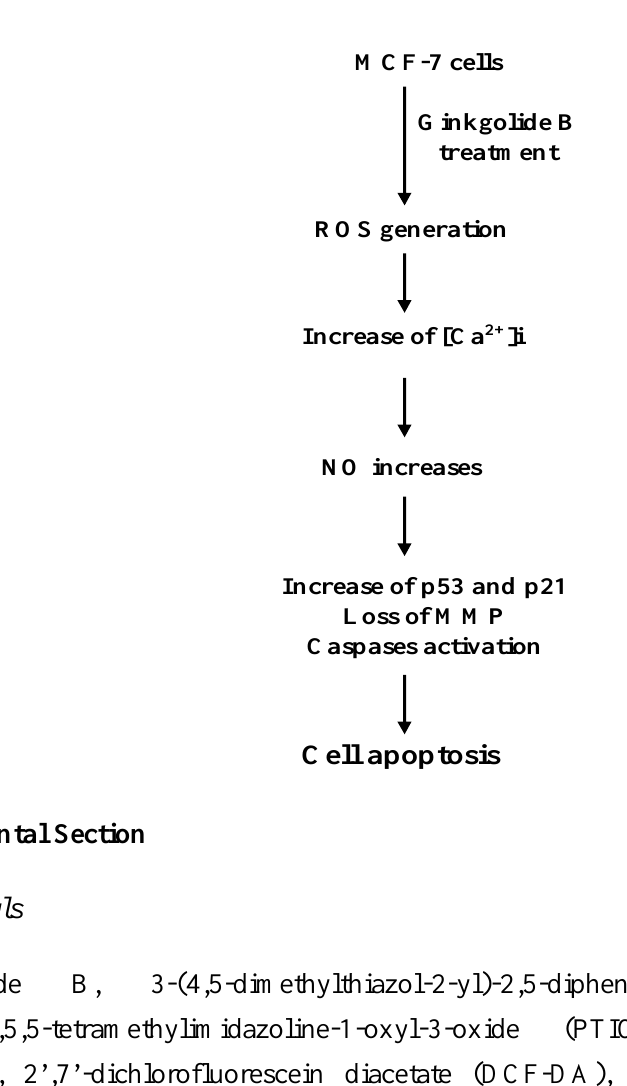
Figure 8. Scheme of events occurring during ginkgolide B-induced cell apoptosis in MCF-7